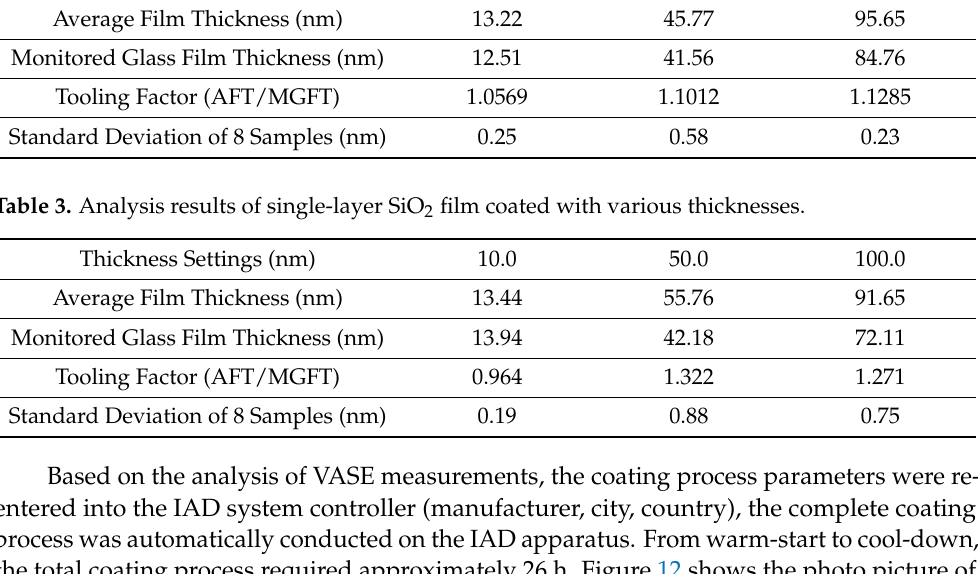
Table 2. Analysis results of single-layer Ta 2 O 5 film coated with various thicknesses. Thickness Settings (nm)